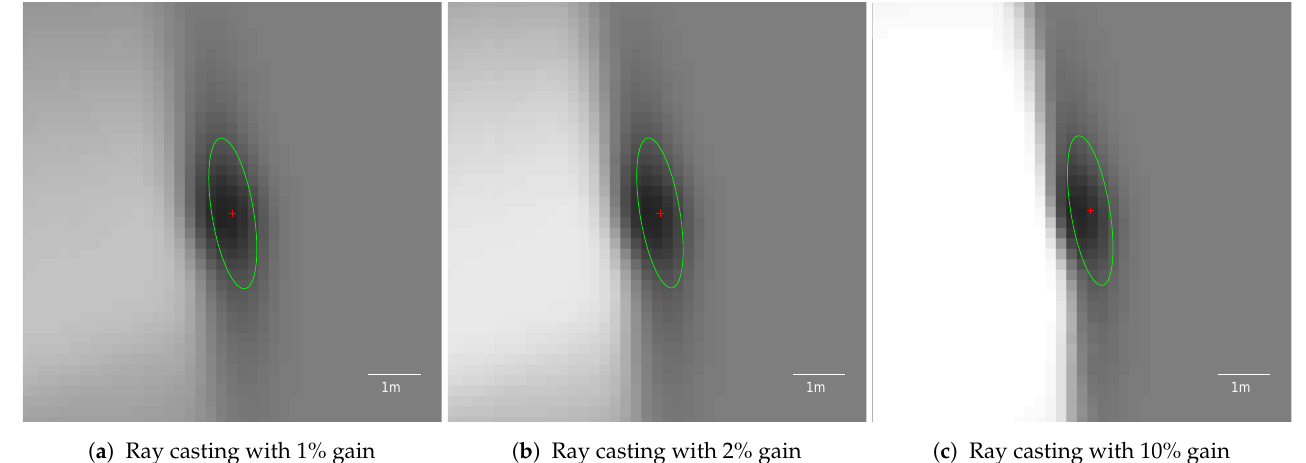
Figure 13. Averaged occupancy grid representations of the pole using different free space evidence gains with a 2D Gaussian sensor model. Each snapshot presents the pole located 10 m from the left side of the vehicle, captured when the host was 10 m awawy longitudinally.